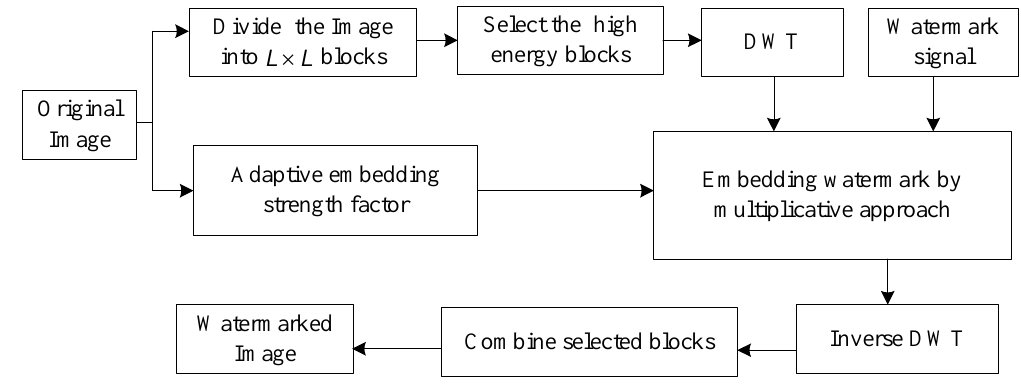
Figure 1. Flowchart of the proposed watermark embedding